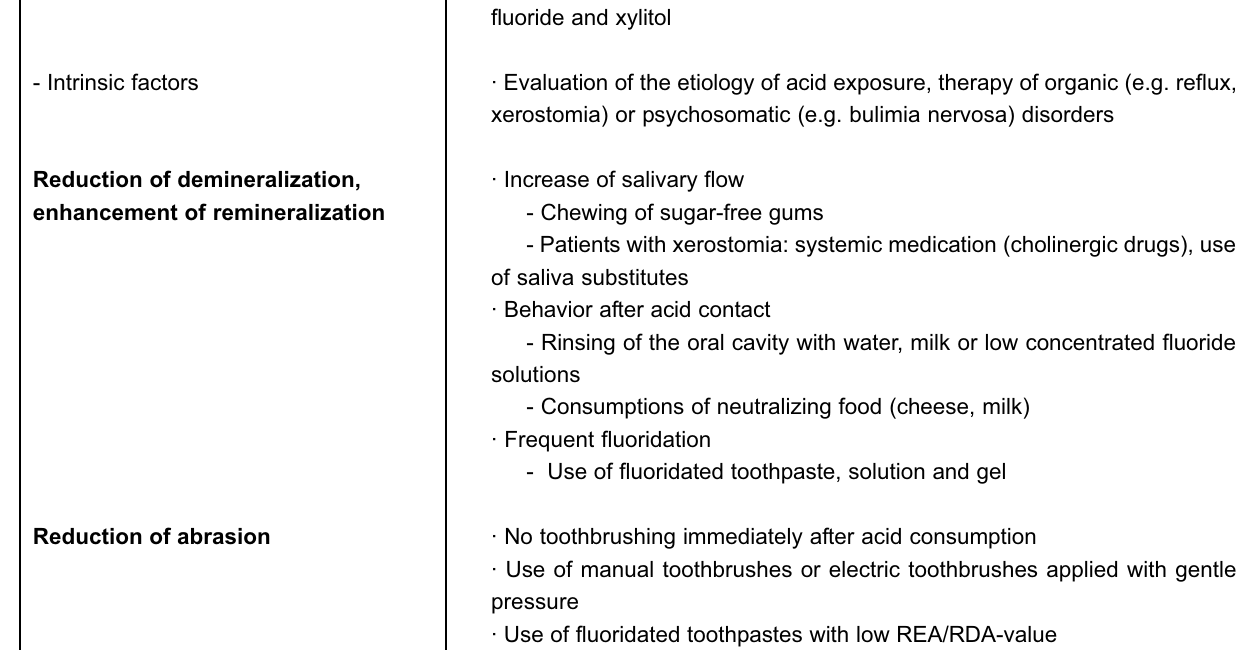
FIGURE 5- Preventive measures for patients with increased risk for